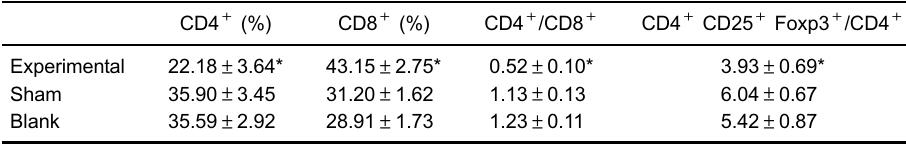
Table 2. T-cell subset distribution among the spinal tuberculosis experimental, sham-operated and blank groups.